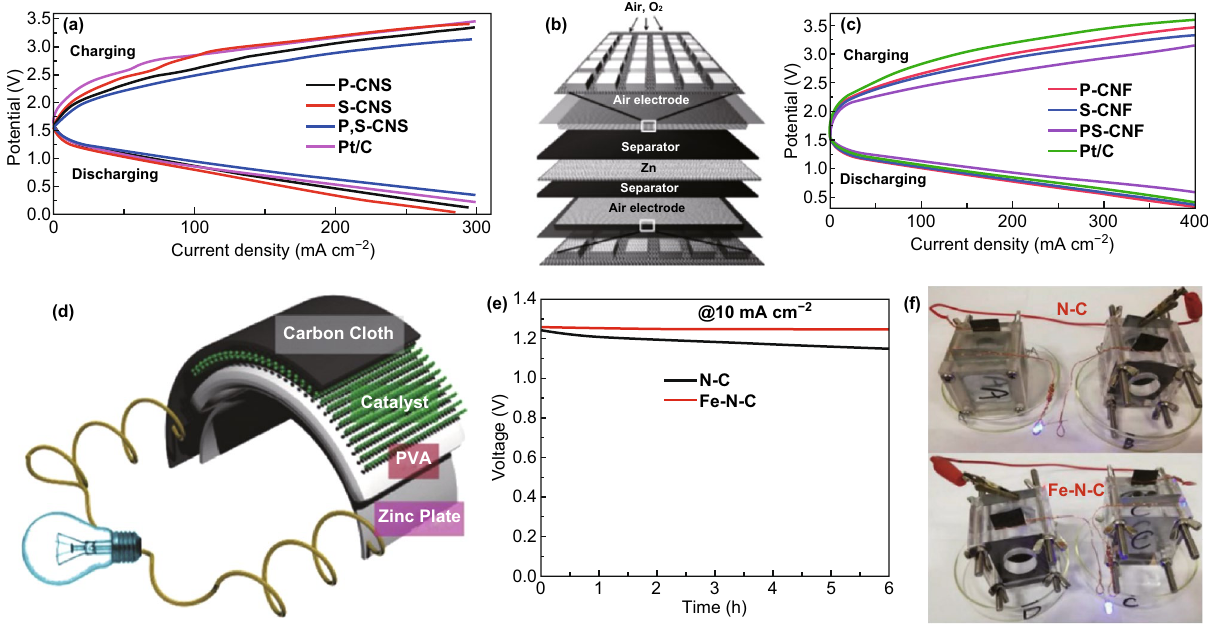
Fig. 26 a Three-electrode ZABs charge and discharge polarization plots of commercial Pt/C, P-CNS, S-CNS, and P, S-CNS catalyst as air elec- trodes. b Schematic representation for the tri-electrode ZABs. Reproduced with permission from Ref. [158]. c Charge and discharge polariza- tion curves for three-electrode ZABs with P-CNF, S-CNF, PS-CNF, and Pt/C catalysts as both air electrodes. d Schematic representation of the all-solid-state rechargeable Zn–air battery performance with N-GCNT/FeCo-3 acting as the air cathode. Reproduced with permission from Ref. [160]. e Galvanostatic discharge curves of the N–C or Fe–N–C cathode at the specific discharge current density of 10 mA cm −2 . f Photograph of blue-light LED powered by two primary Zn-air batteries connected in series with N–C or Fe–N–C as the cathode catalyst. Reproduced with permission from Ref. [161]. Copyright permissions from Wiley–VCH, American Chemical Society, Elsevier, and Royal Society of